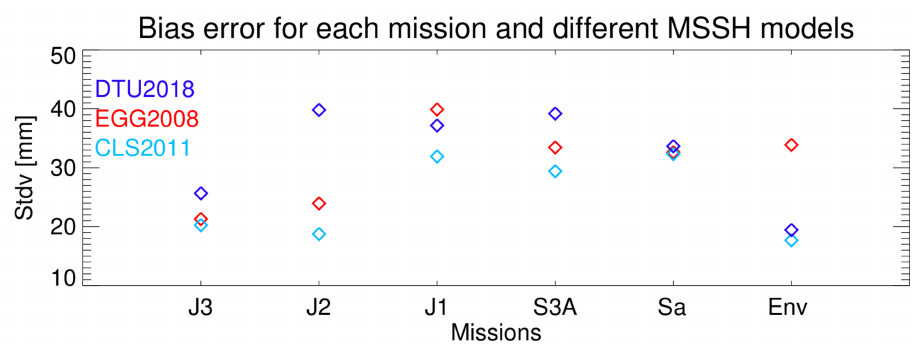
Figure 2. RMS of mean position corrections derived from one quasigeoid and four MSSH models for the virtual/tide gauge station pairs at FINO1 (F1), Borkum Südhafen (Bor), Wangerooge Nord (Wan), LT Alte Weser (AW), Helgoland Binnenhafen (Hel), Wittdün (Wit), Sylt (Syl) and FINO3 (F3). To find the model most suitable in the region, we calculated the mean regional bias for each mission based on all station pairs. The number of accurate collocated stations depends on the mission and varies between three and eight pairs (cf. Table 4). The standard deviation of these mission biases is shown in Figure 3. The closest agreement for all missions is found for the CLS2011 model. The most recent models CLS2018 and DTU2021 show far less consistent results (not shown). Therefore, we calculated the mean position correction based on the CLS2011 model.